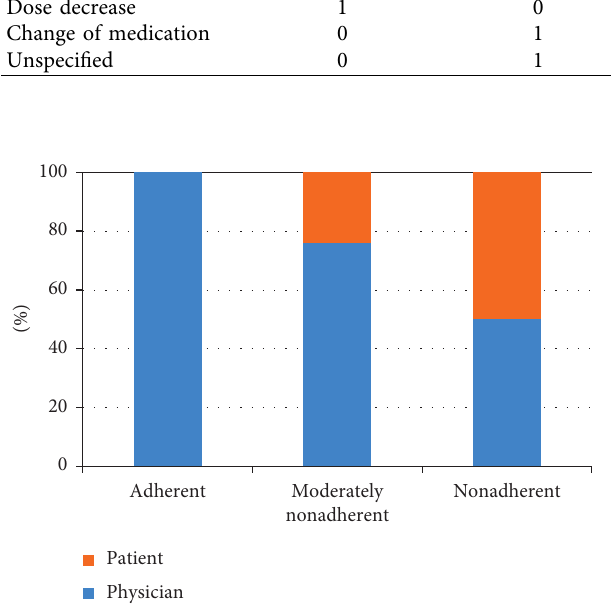
Figure 3: Initiators of medication changes in Parkinson’s disease patients after